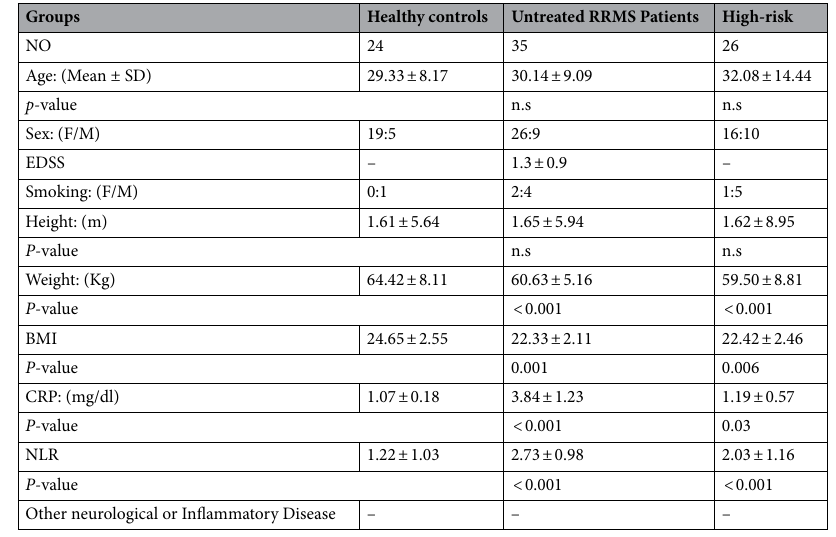
Table 1. Baseline demographic and clinical characteristics of participants of study. EDSS Expanded disability status scale with ranging 0–10, MS multiple sclerosis, RRMS relapsing–remitting multiple sclerosis, CRP C-reactive protein, NLR neutrophil–lymphocyte ratio.